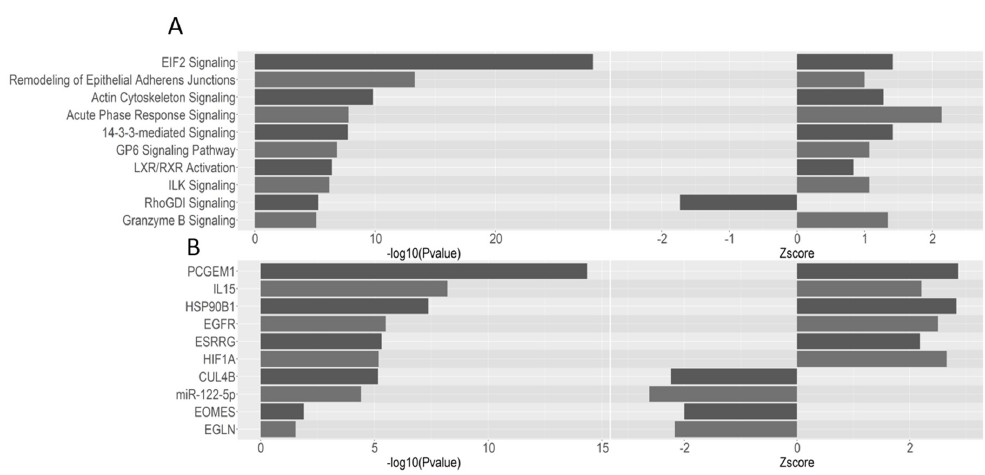
Figure 5. Ingenuity pathway analysis (IPA) of P-M vs. P-NM proteomics data. Unique protein IDs present in at least 50% of samples were analysed using IPA with fold changes and p values used as metrics. ( A ) IPA pathway analysis. ( B ) IPA upstream regulator analysis.